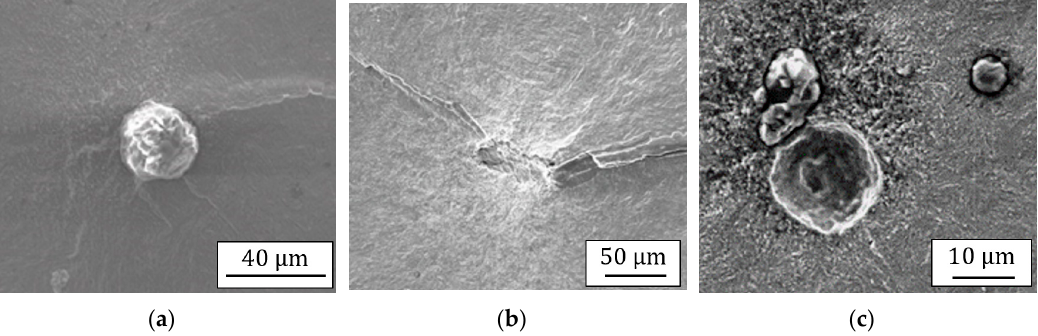
Figure 5. Types of inclusions originating the VHCF failures: ( a ) globular oxide-type inclusion, ( b ) stringer-type inclusion, ( c ) cluster of small inclusions.